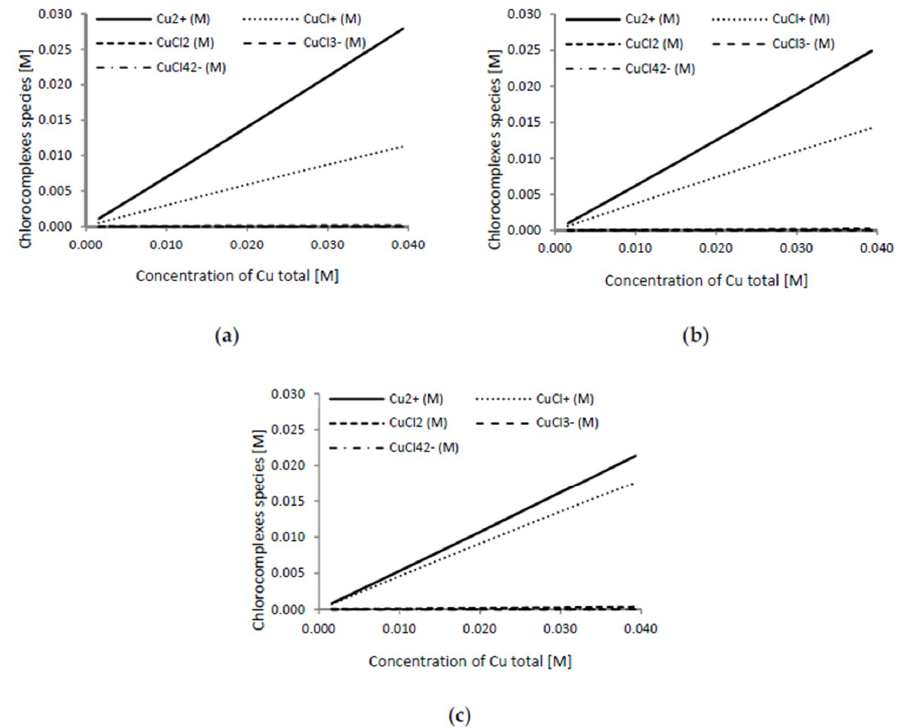
Figure 5. Predicted copper complexes (M) at a cupric concentration range from 0.1 to 2.5 g L −1 , and as a function of chloride concentration: ( a ) [Cl − ] = 5 g L −1 ; ( b ) [Cl − ] = 7 g L −1 ; and ( c ), [Cl − ] = 10 g L −1 . Minerals 2019 , 9 , x FOR PEER REVIEW